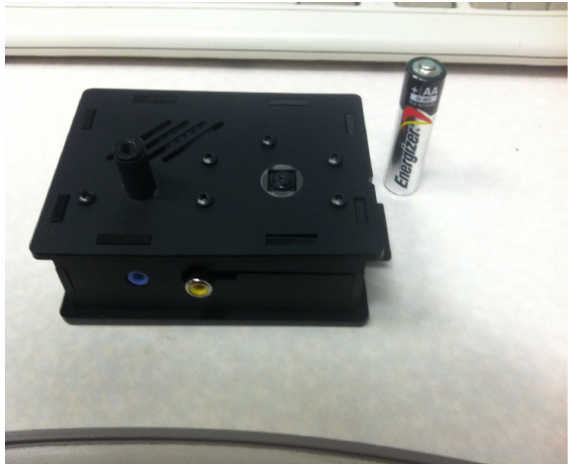
Figure 3. MLX90614ESF-BCI-000-TU-ND sensor, Pi-NoIR, and Raspberry Pi in a Nwazet Pi Camera Box